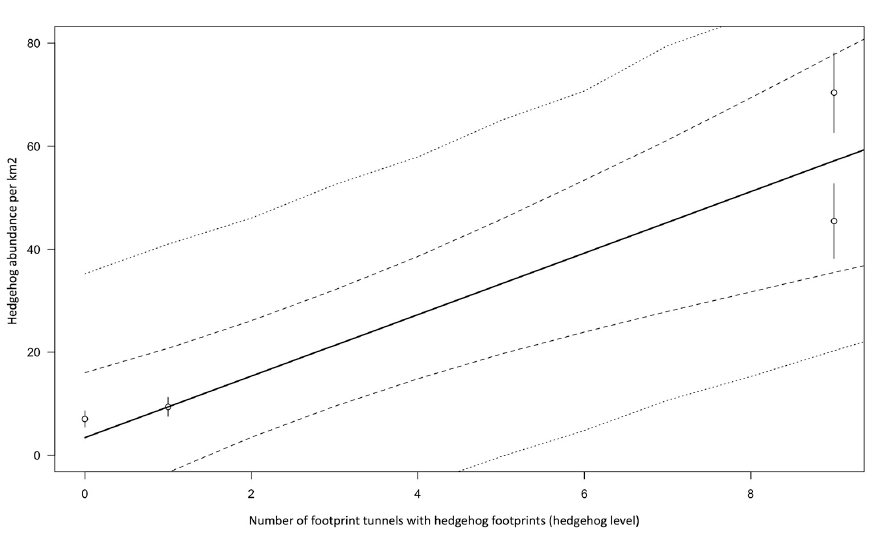
Figure A2. Linear regression between the abundance measures from the capture-mark-recapture (CMR) study (whiskers indicate confidence intervals of the CMR estimates) as the independent variable and the hedgehog levels from the footprint tunnel study (ranging from 1–10) in the respective area as the dependent variable. Regression line in black with confidence (dashed line) and prediction interval (dotted line).